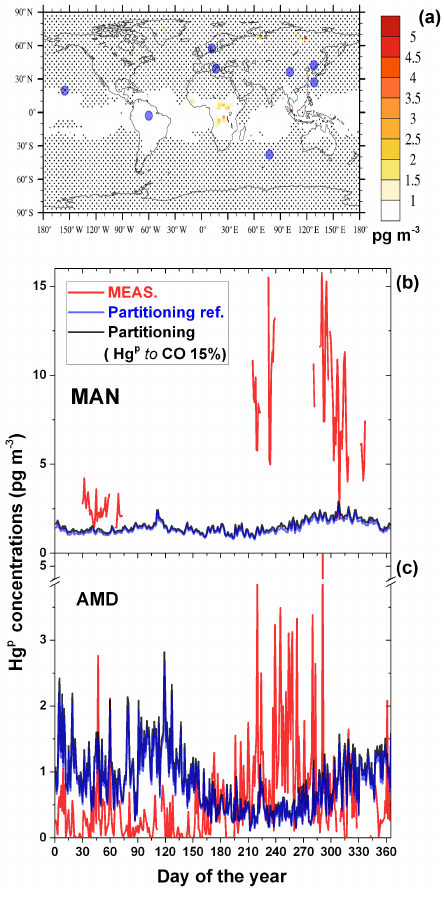
Figure 12. (a) Differences in annual averaged surface Hg P concen- trations as simulated by Partitioning and by Partitioning ref. runs, both including emissions from all sources and the temperature- dependent Hg II gas-particle partitioning as implemented in Amos et al. (2012). Black dots indicate that differences are not signifi- cant based on a Student t test at a 95% confidence interval. Bigger blue points indicate the locations of measurements sites reported in Table 2. Temporal evolution of daily averaged surface Hg P con- centrations are measured at Manaus (MAN) and Amsterdam Island (AMD) for the entire 2013, compared with the modelled values from the same sensitivity runs.